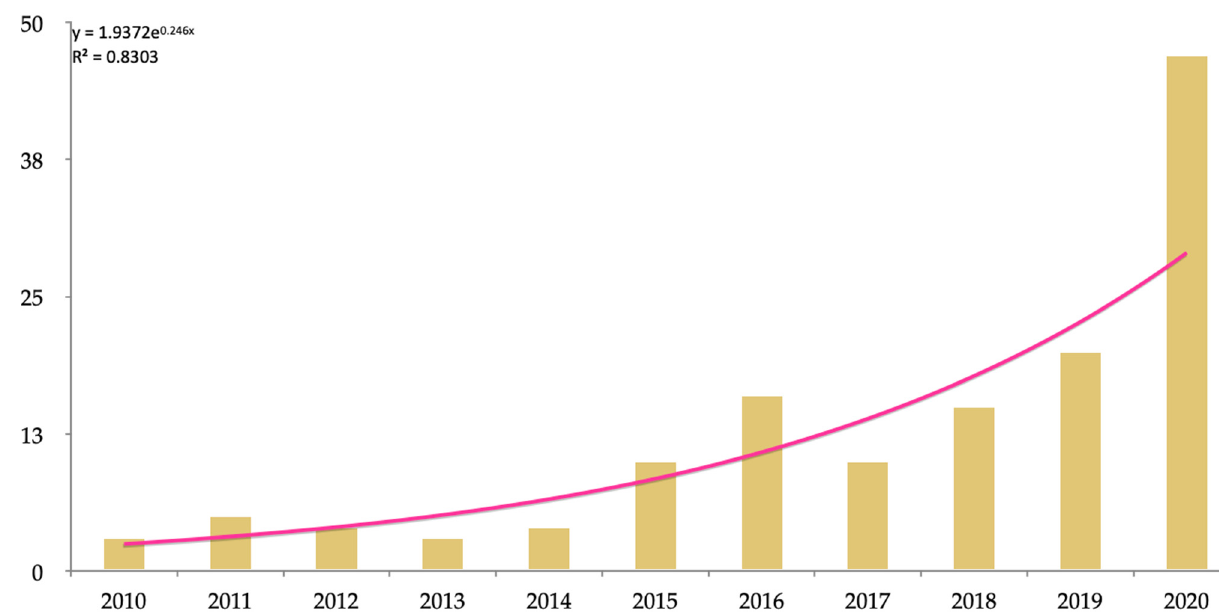
Figure 4. Distribution of the documents per year and exponential curve of publication.